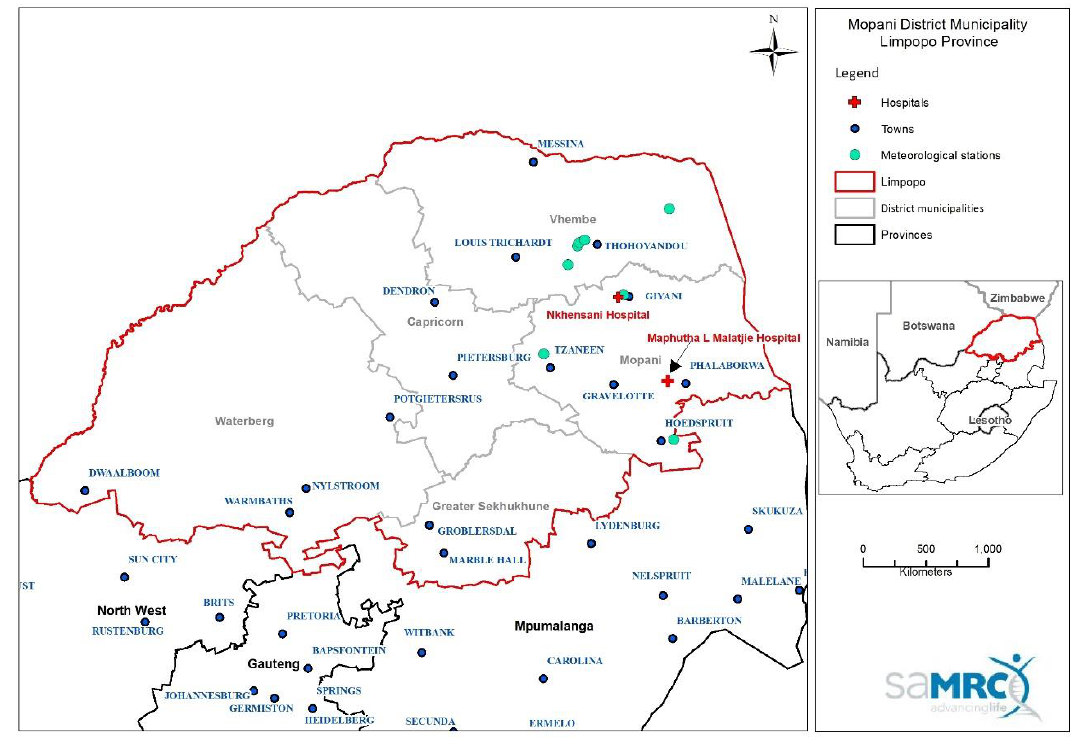
Figure 1. Location of the two hospitals and meteorological stations in the study site in Limpopo Province, South Africa (Map produced by the SAMRC).